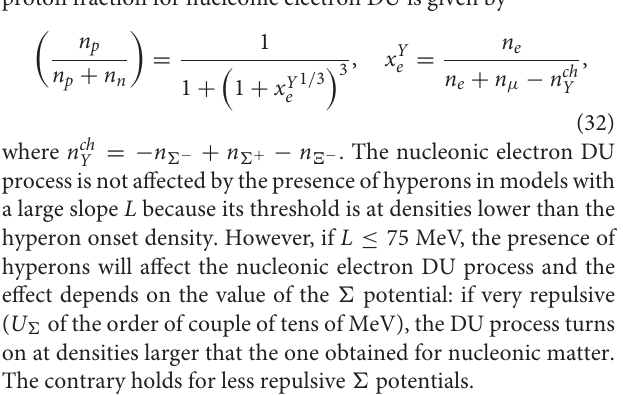
FIGURE 4 | Particle fractions for U 6 U 6 10 MeV (color lines with marks), npe µ matter (solid lines), obtained = − with model TM1 ωρ